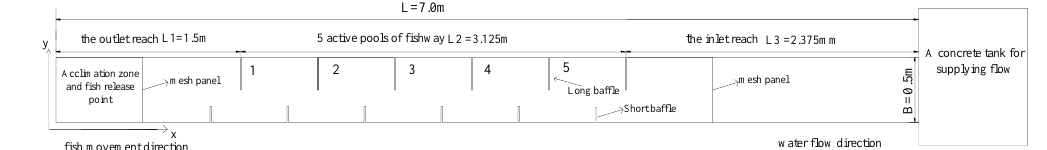
Figure 1. The planform of the experimental vertical slot fishway.